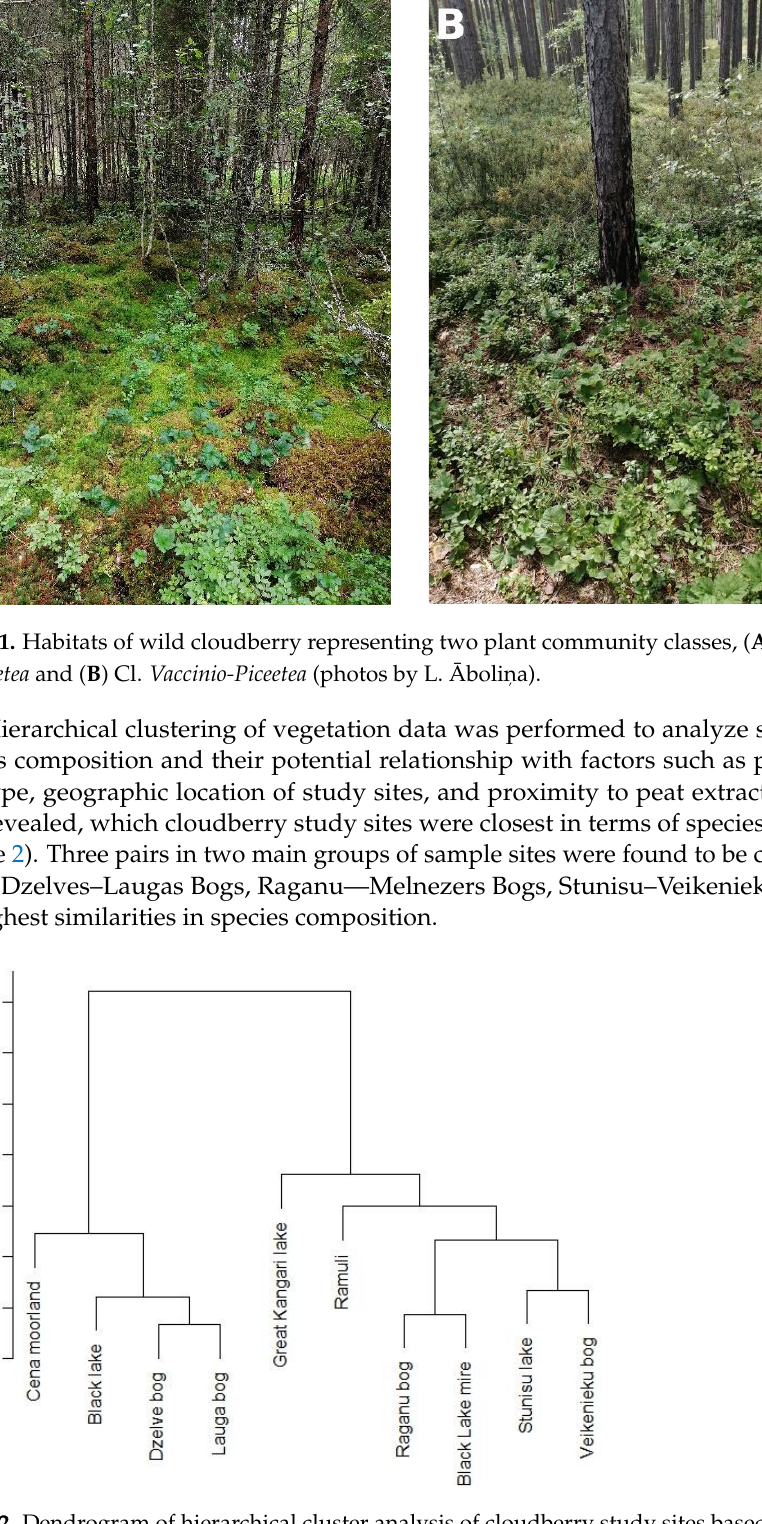
Figure 2. Dendrogram of hierarchical cluster analysis of cloudberry study sites based on vegetation composition. Levels of similarity between different sites are indicated by vertical linkage distance.